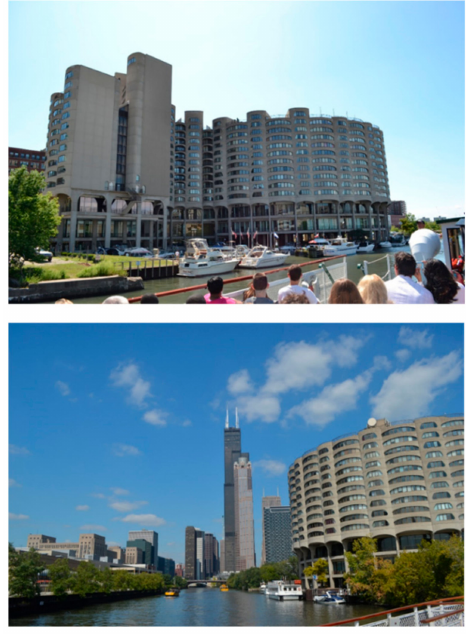
Figure 16. At the southern end of the boat tour, study participants admired the River City complex (top). They also liked the city skyline centered by the Willis Tower, the city’s tallest building